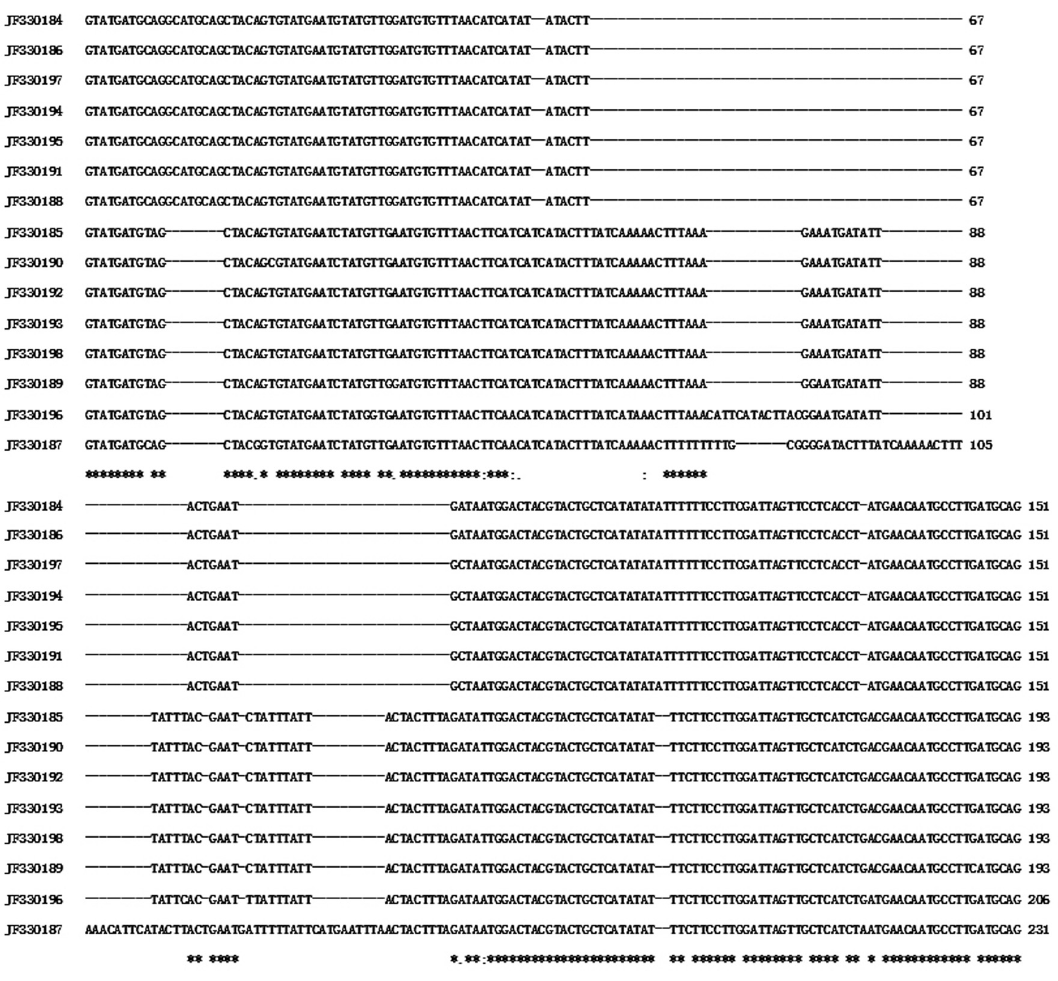
Figure S1 - Alignment of the intron IV sequence of the WAG-2 gene from different